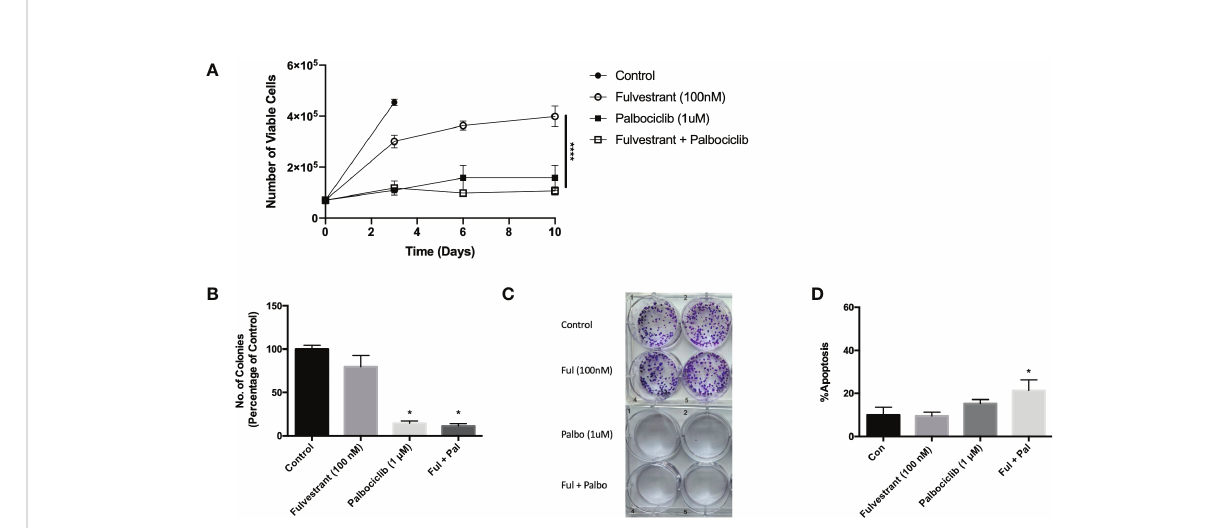
FIGURE 1 Fulvestrant in combination with Palbociclib sensitizes MCF7 cells. Cells were treated with Fulvestrant (100 nM), Palbociclib (1 µM) or the combination for 6 days (A-C) . (A) Viability of MCF7 cells was monitored based on trypan blue exclusion at indicated days following drug exposure (n=3). ****P ≤ 0.0001 indicate statistical signi fi cance of each condition compared to Fulvestrant alone. (B) After exposure for 6 days, cells were incubated in fresh medium for 7 days. Quanti fi cation of colonies expressed as relative percentage compared to controls (n=3). (C) Representative colony formation 7 days after drug removal by crystal violet staining. (D) Apoptosis was measured using annexin V/PI staining at the end of the 6-day treatment and fl uorescence was measured using fl ow cytometry (n=3). Unless stated otherwise, data were from three independent experiments. *P ≤ 0.05 indicate statistical signi fi cance of each condition compared to control as determined using two ‐ way ANOVA with Sidak's post hoc